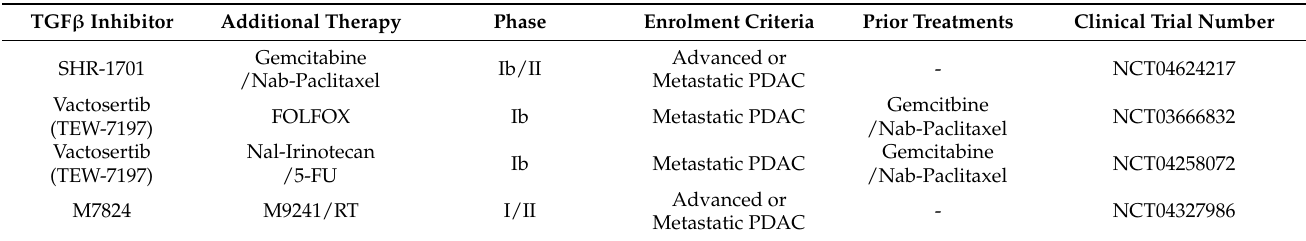
Table 2. Ongoing clinical trials exploring TGF β inhibitors in PDAC patients that have yet to post